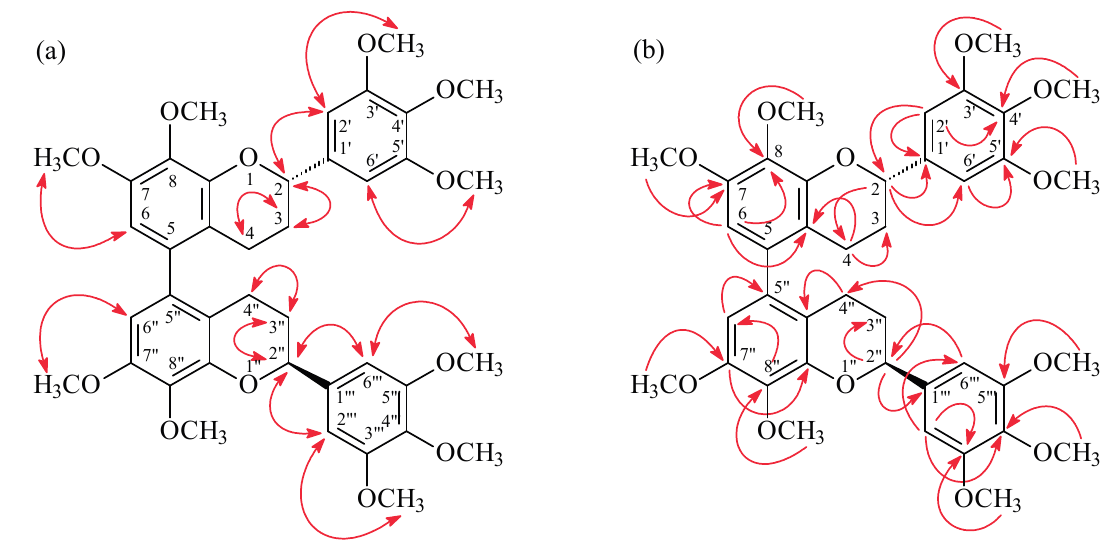
Figure 3. Key NOESY ( a ) and HMBC ( b ) correlations of 1